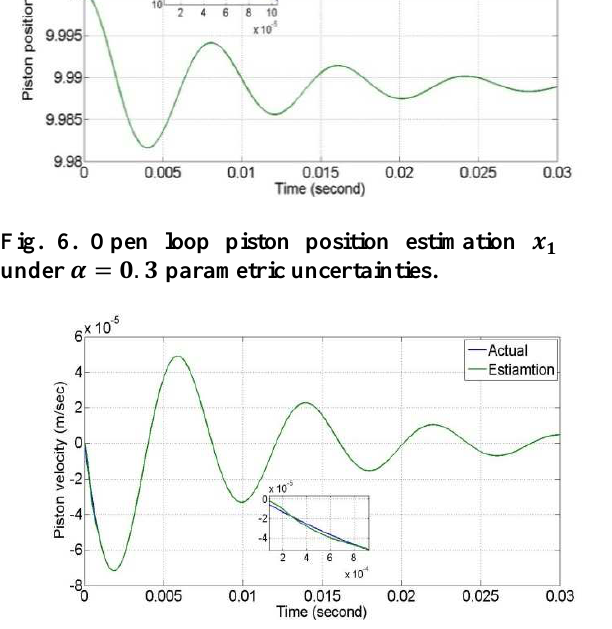
Fig. 9. Open loop parametric